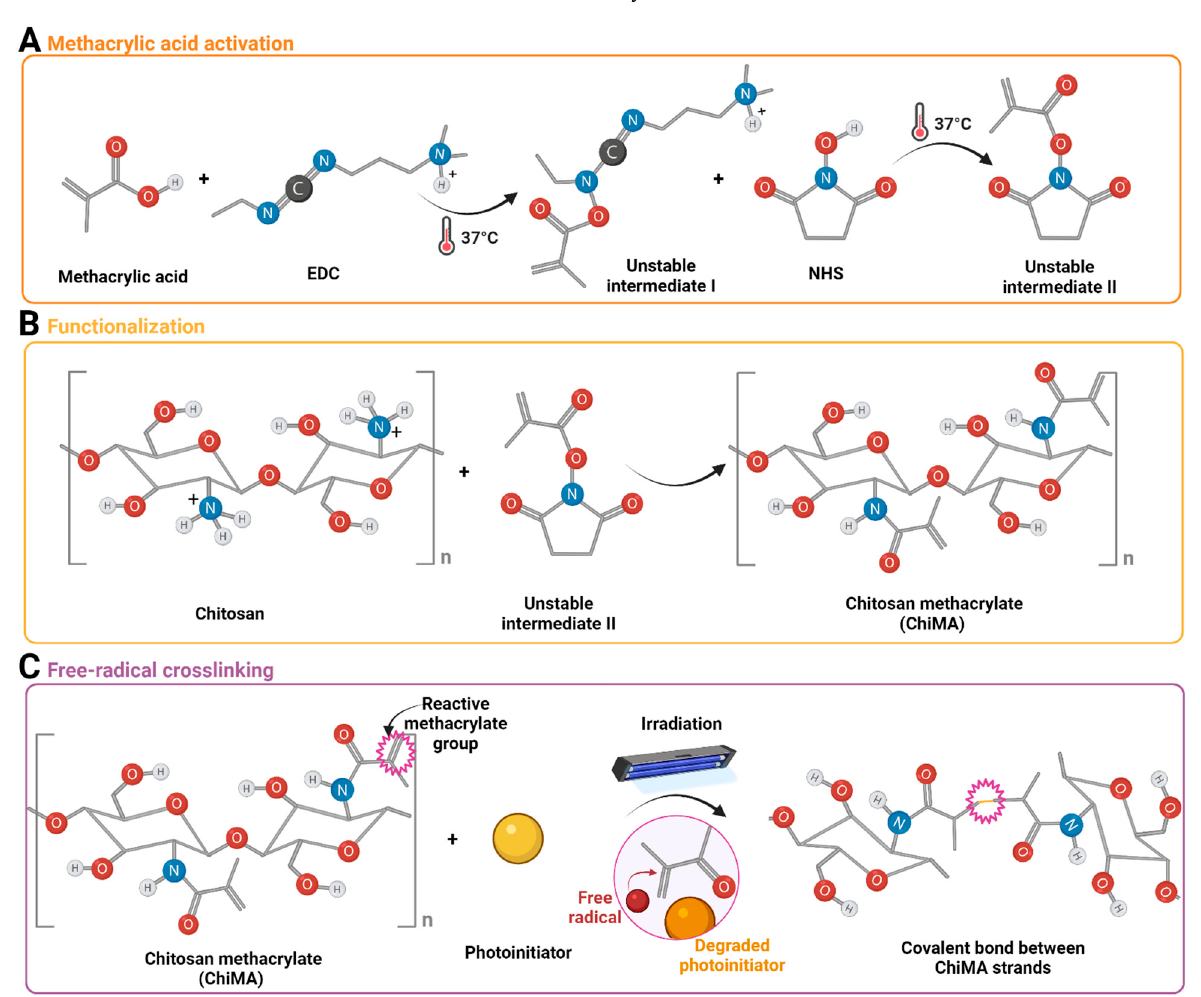
Figure 1. ( A ) Activation of methacrylic acid mediated by EDC and NHS. ( B ) Chemical conjugation of methacryloyl groups to the free amines of glucosamine units in chitosan monomers. ( C ) Methacryloyl group destabilization and crosslinking induced by the light-directed degradation of a photoinitiator (riboflavin).